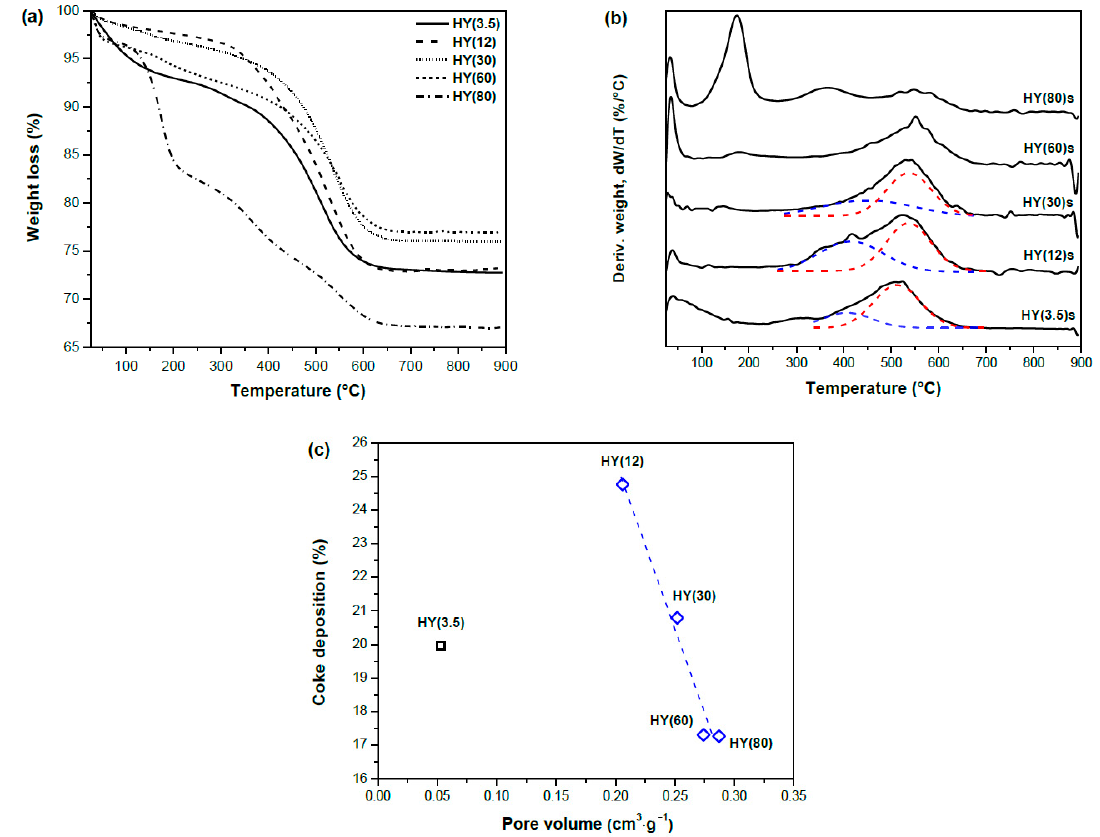
Figure 13. ( a ) TGA thermograms, ( b ) DTG analysis of the spent zeolites and ( c ) correlation between the fresh catalyst pore volume and the coke amount of the spent zeolites.